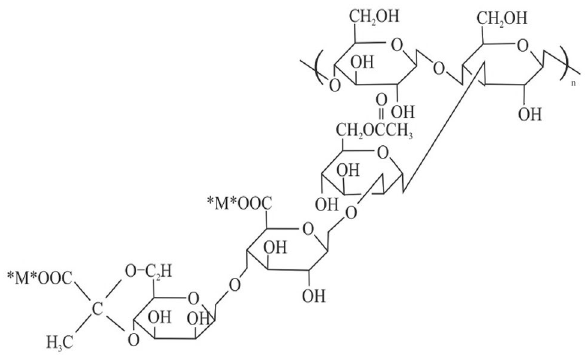
Fig. 2 Structure of xanthan gum [45]